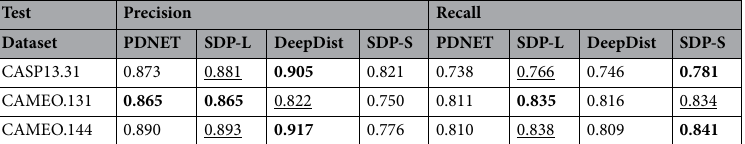
Table 5. Precision and recall values for distance map to contact map direct conversion and for all residue pairs. For both metrics, the larger the better. The emboldened and underlined values are the best and the second best values respectively.